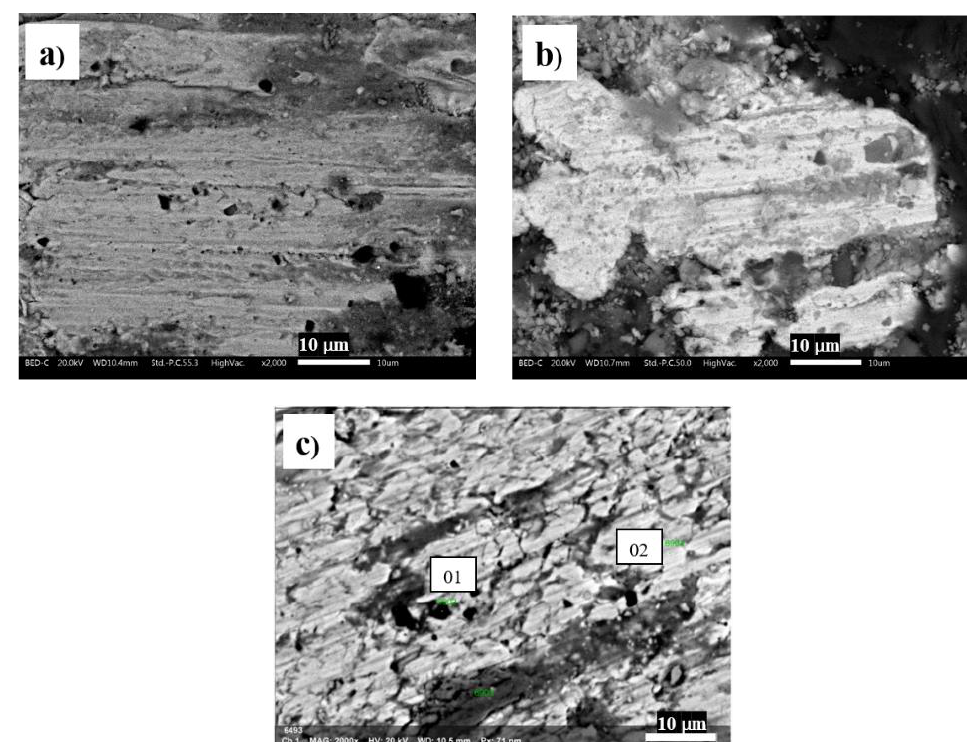
Figure 8. SEM micrographs of the steel fibres present on the surfaces of the pins that worked as primary plateaus: ( a ) M0, ( b ) M0_G and ( c ) M0_CN. The numbers 01 and 02 show the positions of the local EDX analysis (Table 6).